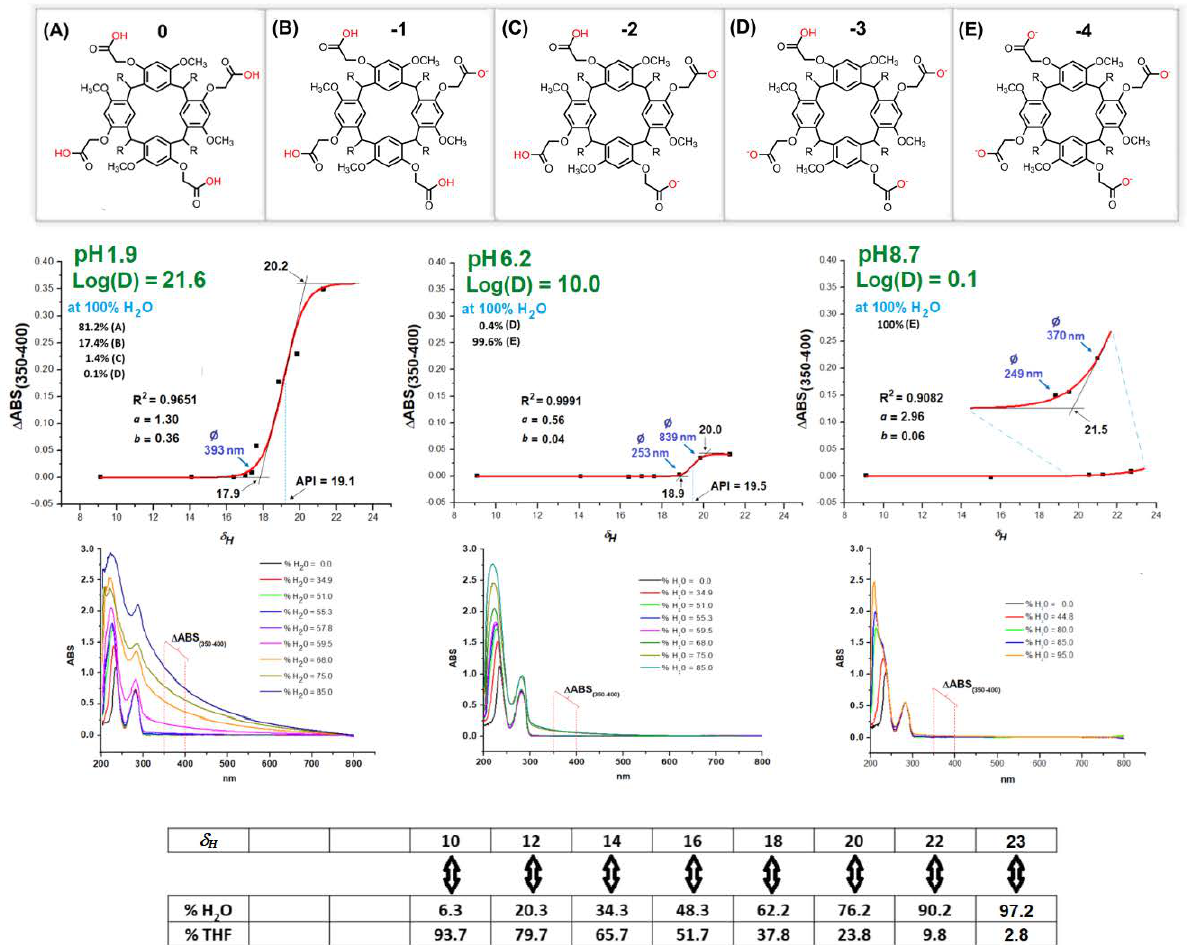
Figure 6. The sigmoidal aggregation profile and the corresponding UV-visible spectra of resorc[4]arene R2 as obtained in THF/water solvent systems at fixed pH values of the aqueous component. Regression analysis to fit the experimental data was performed according to Equation (2). Subfigures ( A – E ) represent the deprotonation states of R2 at the analyzed pH values of 1.9, 6.2 and 8.7 (the relevant percentages are shown next to the respective aggregation